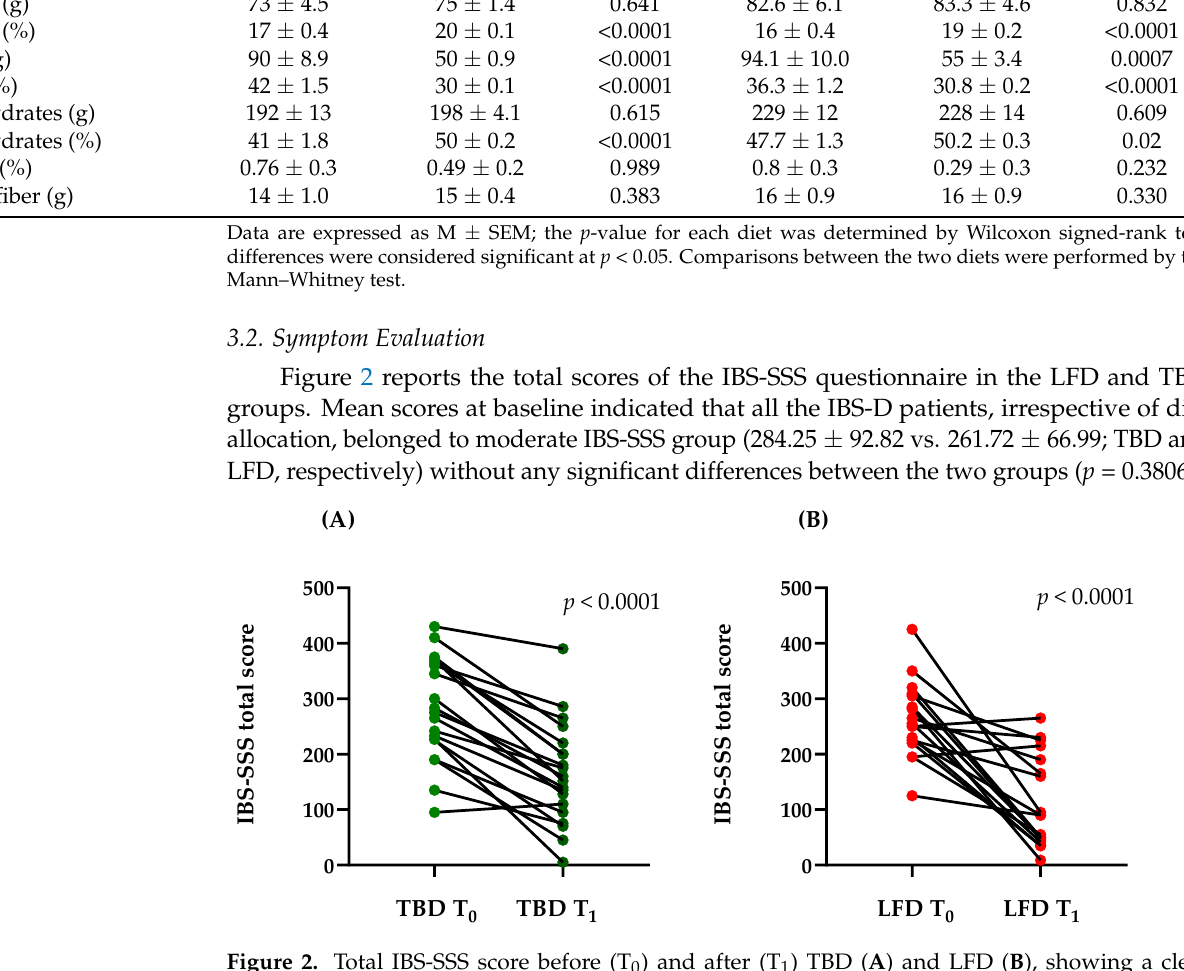
Figure 2. Total IBS-SSS score before (T 0 ) and after (T 1 ) TBD ( A ) and LFD ( B ), showing a clear reduction of the mean IBS-SSS total score after diet from moderate-to-mild range (284.25 ± 92.82 vs. 164.05 ± 90.73 and 261.72 ± 66.99 vs. 113.78 ± 82.48; TBD and LFD, respectively). Data are expressed as mean ± standard deviation (SD). Statistical analysis: Wilcoxon rank-sum test. Abbreviations: LFD, low-FODMAPs diet; TBD, tritordeum-based diet; IBS-SSS, irritable bowel syndrome (IBS) Severity Scoring System.